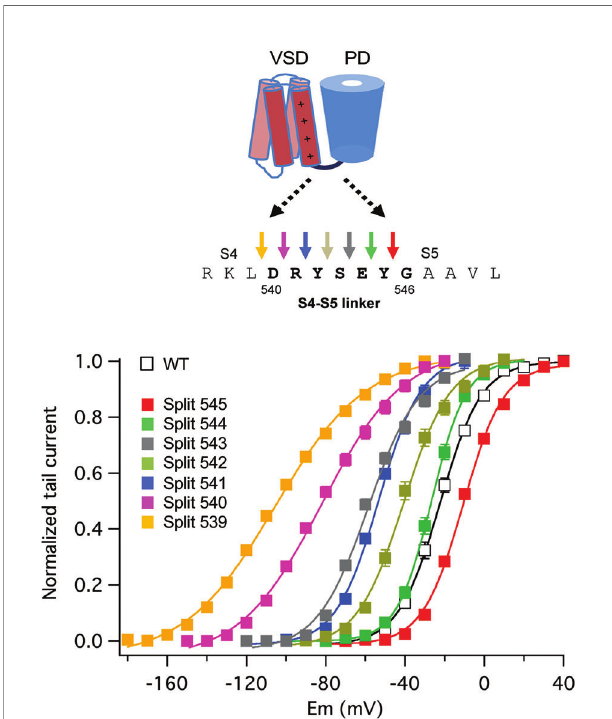
FIGURE 6 | Gradual modi fi cation of activation voltage dependence caused by breaking the covalent linkage at different points along the S4 – S5 linker sequence in split erg1 (Kv11.1/hERG) channels. A schematic view of the transmembranal core of a channel subunit at the top is combined with the sequence of the S4 – S5 linker region and a set of coloured arrows for each covalent break used to generate the split channels listed below. Plots of normalized conductance/voltage relationships for the different splits are shown in the graph. Plots were obtained from tail current measurements upon repolarization. Tail currents were recorded in oocytes expressing the indicated channel variants, submitted to 1-s depolarization pulses at different potentials in 10 mV intervals from a holding potential of -80/-100 mV, followed by a repolarization step at -50 (splits 545, 544, 543 and 542), -70 (wild type/WT and split 541), -120 (split 540), and -140 (split 539) mV. Different repolarization potentials were used to ensure closing of the different constructs and proper quanti fi cation of tail current magnitudes. Continuous lines are Boltzmann fi ts to the data. For details see De la Peña et al., 2018a, from which the Figure has been reproduced under Creative Commons Attribution 4.0